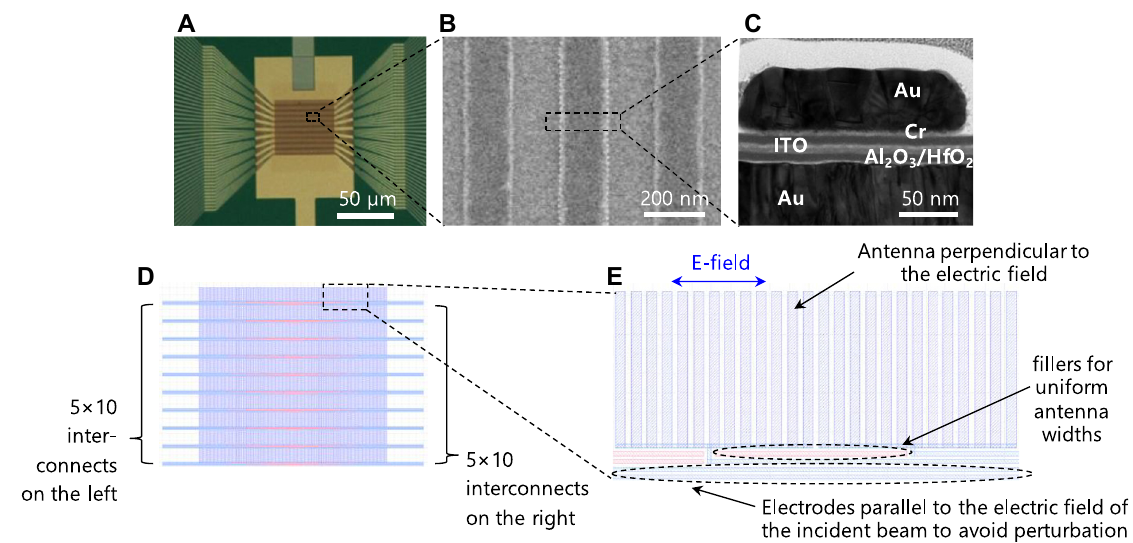
Figure 3: Fabrication of the 10 × 10 two-dimensional tunable metasurface. (A) Top microscopic image. (B) SEM image of antennas in single pixel. (C) TEM cross-sectional image in single antenna area of active metasurface array device for two-dimensional beam steering. (D) Graphic design system (GDS) layout for the ebeam patterning of both the antenna, the electrodes, and the fillers. (E) Magnified view of the GDS layout that shows the antenna perpendicular to the electric field, fillers for uniform antenna width, and the electrodes parallel to the electric